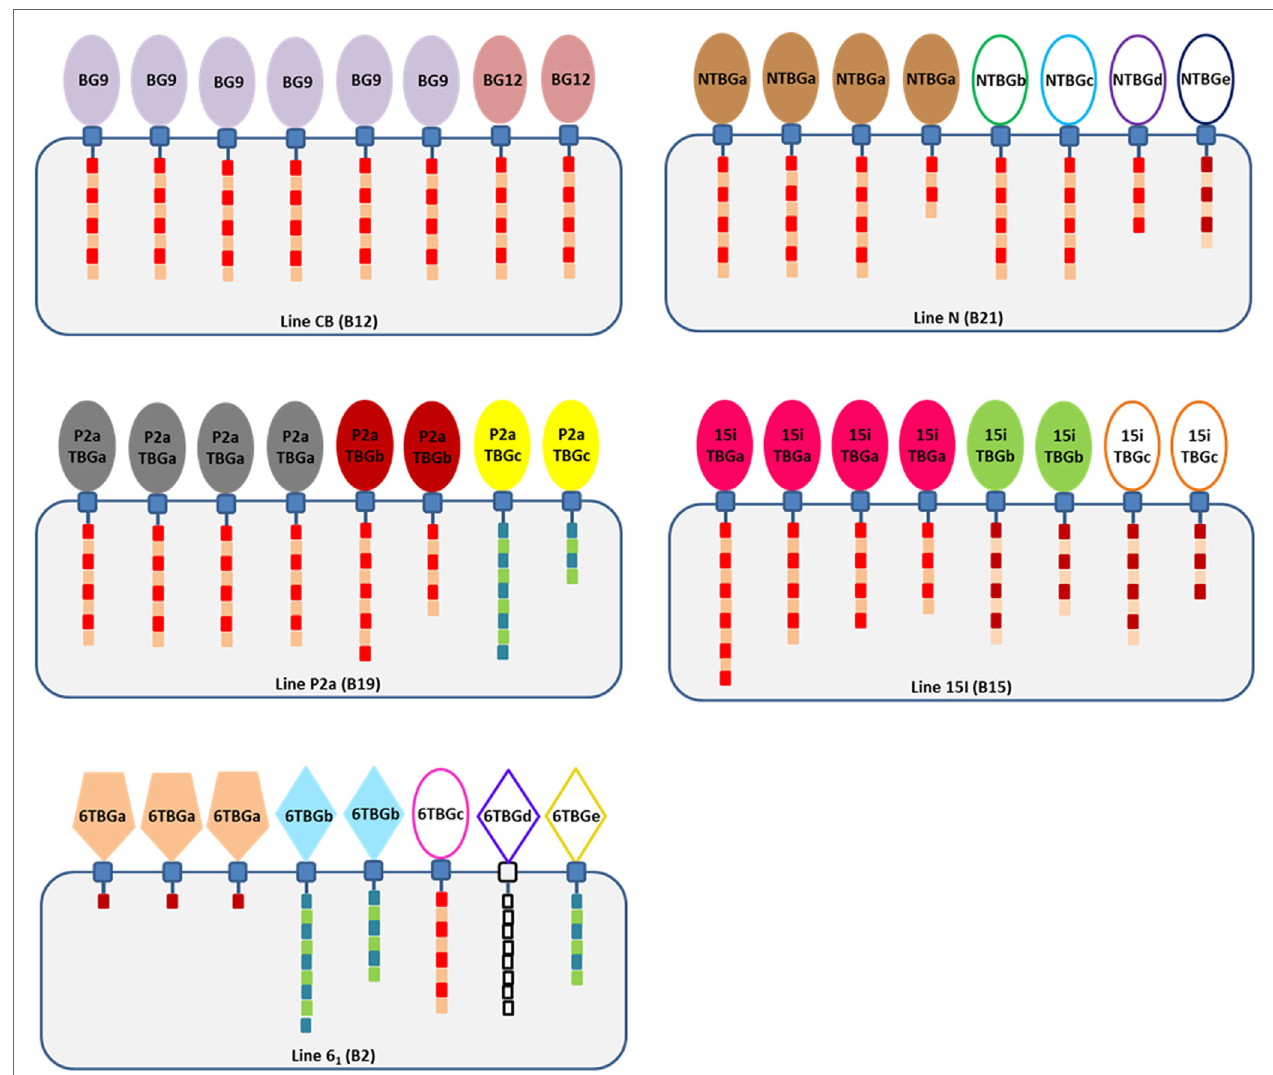
FigUre 10 | Cartoon summary of the findings, showing that there are no expressed sequences identical between the four chicken lines but that line 6 1 has sequences identical to genes of the B12 haplotype (which, however, are not expressed in T cells of the B12 haplotype), that most expressed sequences are from the B8-B9-B12 clade although line 6 1 (B2) has a dominantly expressed BG sequence of the BG13 clade and two subdominant sequences from the BG5-BG7- BG11 clade, and that cytoplasmic tails are mostly type 2a and that the length varies due to alternative splicing (intron read-through). The cartoon shows BG proteins in cells of each haplotype, with the numbers of each protein reflecting the ratio of different sequences in that haplotype. Extracellular Ig-V domains are represented by shapes to indicate relationship to clades of BG genes from the B12 haplotype (ovals, BG8-BG9-BG12 clade; pentagons, BG13 clade; and diamonds, BG5-BG7-BG11 clade) and by color (colors as in Figure 2 , with those sequences found in only one PCR represented by ovals and diamonds not filled with color); cytoplasmic tails indicated by boxes representing heptad repeats, with lengths correlated with the length of the tail taking into account alternative splicing and with colors representing the clade (type 1, blue and green; type 2a, bright red and brown; type 2b, dark red and brown; and 6TBGd, white since no data are